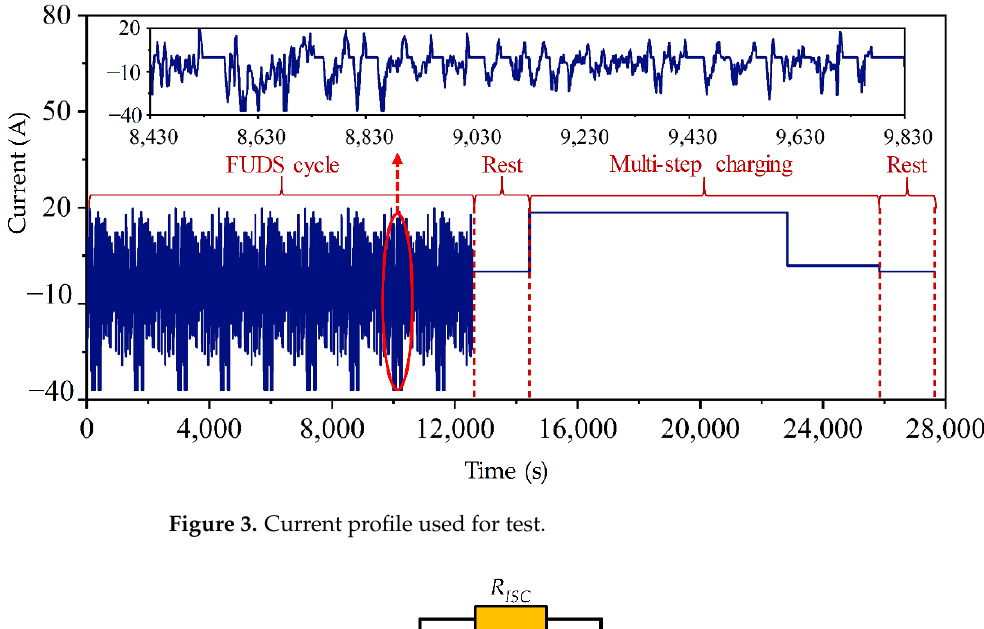
Figure 3. Current profile used for test.